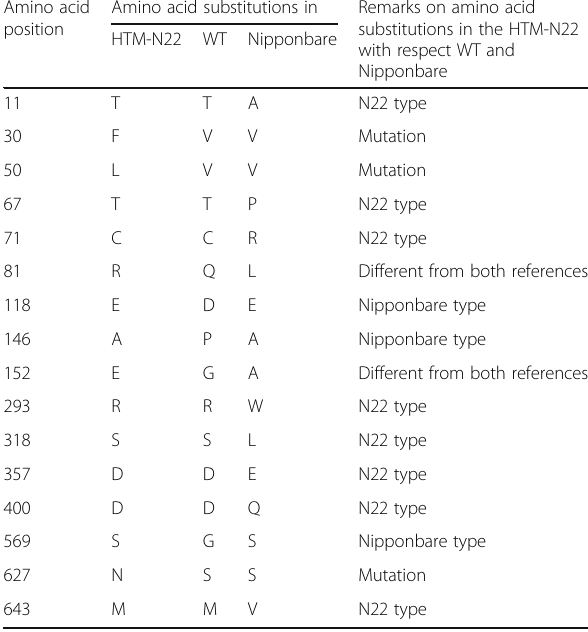
Table 4 Summary of amino acid substitutions in HTM-N22 as compared to WT with Nipponbare as reference